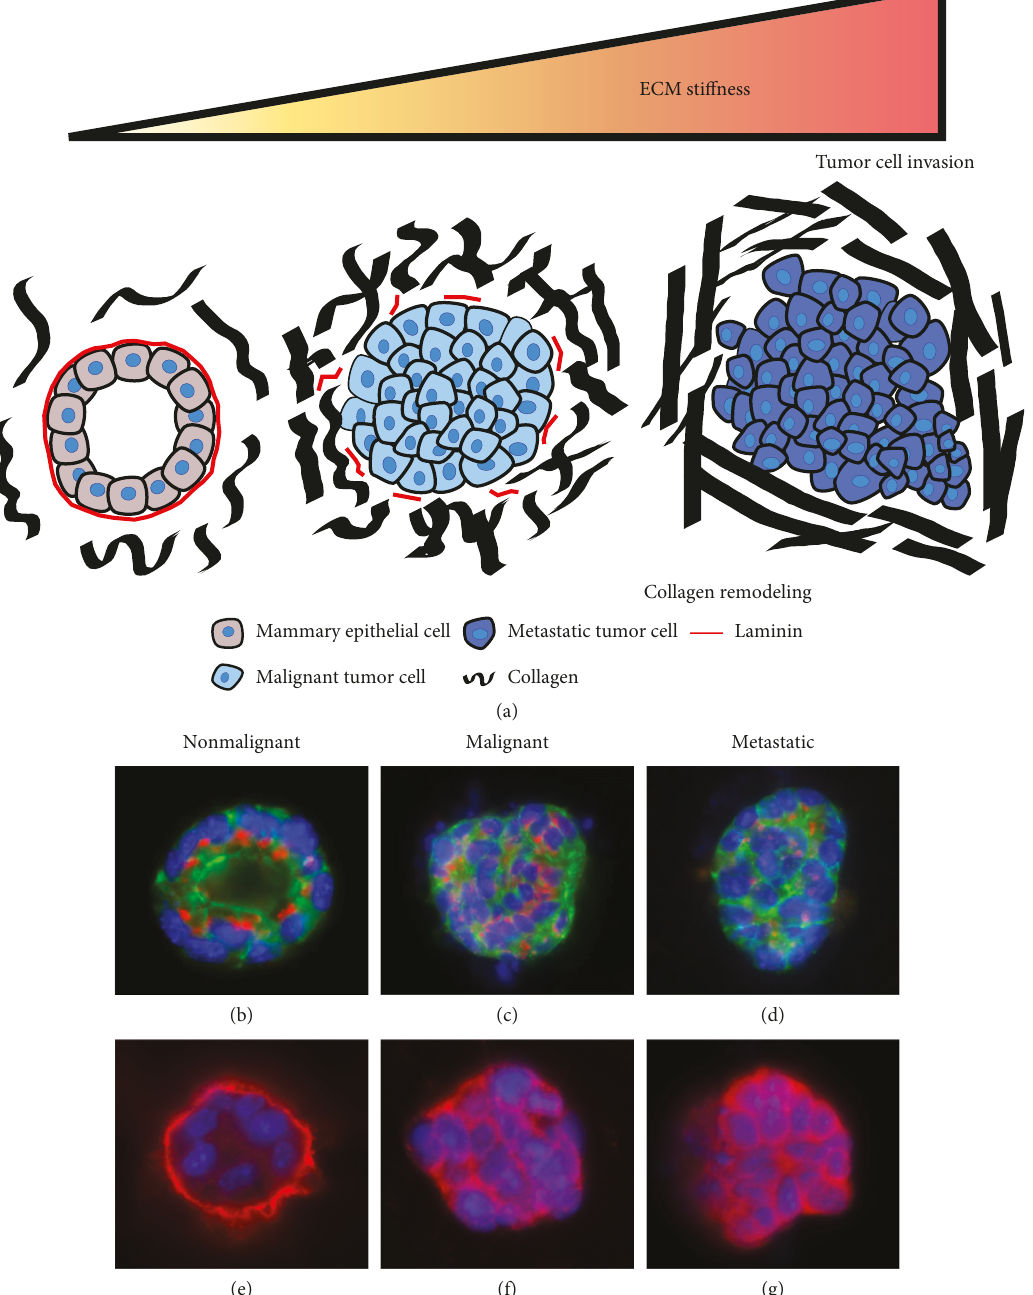
Figure 1: Mechanical cues from the extracellular matrix help drive tumorigenesis. (a) Increasing collagen production and cross-linking causes a stiffening of the extracellular matrix (ECM). This increasing mechanical load on the microenvironment has been shown to alter phenotypic expression of cells towards malignant phenotypes. (b, e) Nonmalignant mammary epithelial cells will form spherical acini with apical/basal polarity, a basement membrane, and a hollow lumen. (c, f) The organized structure is lost in malignant cells, as is the hollow lumen. (d, g) Metastatic cells exhibit similar phenotypes to malignant cells with the loss of apical/basal polarity, basement membrane, and hollow lumen. For images (b–d), mammary spheroids are stained for GM130 (red), DAPI (blue), and actin (green). Images (e, f) show mammary spheroids stained for laminin (red) and DAPI